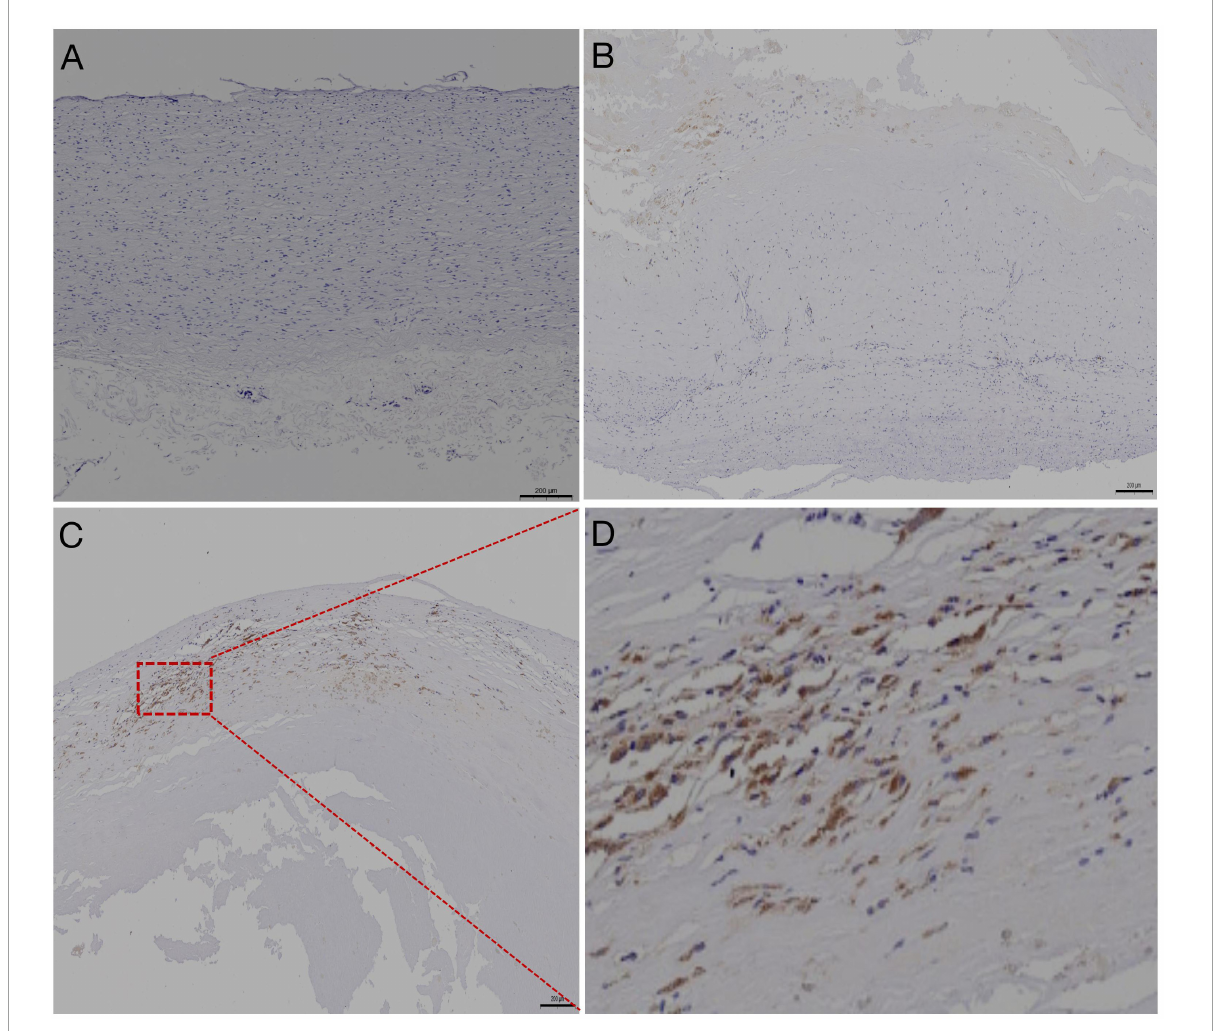
FIGURE3 Representative images of pulmonary artery immunolabeled with anti-CD68 antibodies. (A) Negative immunohistochemical staining of the pulmonary artery from healthy lung transplant donor, scale bars: 200 µ m. (B) Relatively lower abundance of CD68+ macrophages in the non-atherosclerotic lesion of CTEPH, scale bars: 200 µ m. (C) Strong positive immunoreactivity of CD68+ macrophages was found in the atherosclerotic lesion, outlined by the red box, of the pulmonary artery resected by pulmonary endarterectomy. Scale bar: 200 µ m. (D) Magnified view of panel (C)